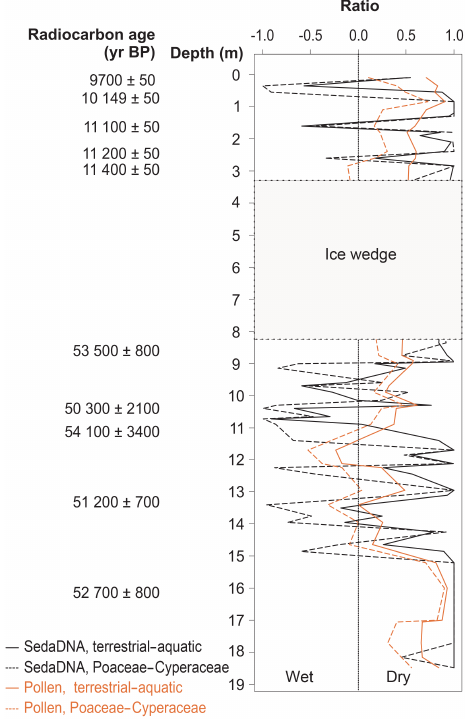
Figure 10. Terrestrial–aquatic (Eq. 1) (line) and Poaceae– Cyperaceae ratios (Eq. 2) (dashed line) of plant sedaDNA (black) and pollen (red). Positive ratios indicate a higher contribution of ter- restrial or Poaceae sequence counts or pollen grains and hence drier conditions. Negative ratios indicate a higher contribution of swamp and aquatic or Cyperaceae sequence counts or pollen grains and hence wetter conditions. Uncalibrated radiocarbon ages are given in years before present